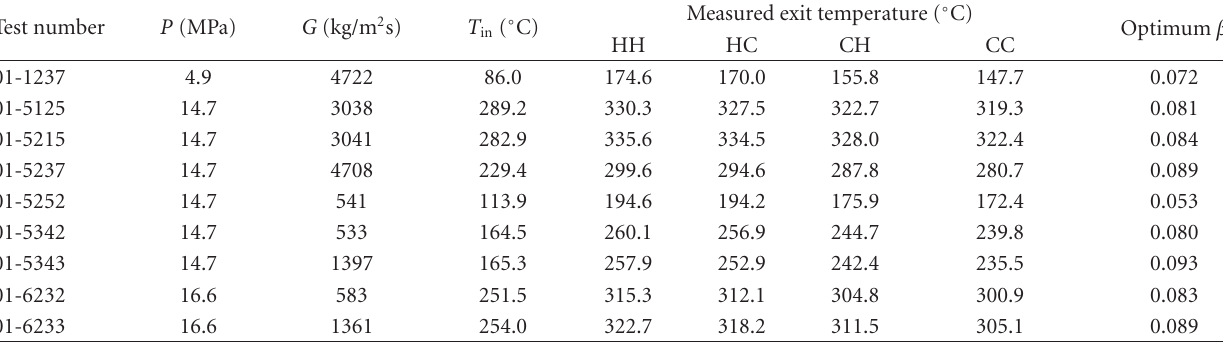
Table 5: Optimum value of β at various operating